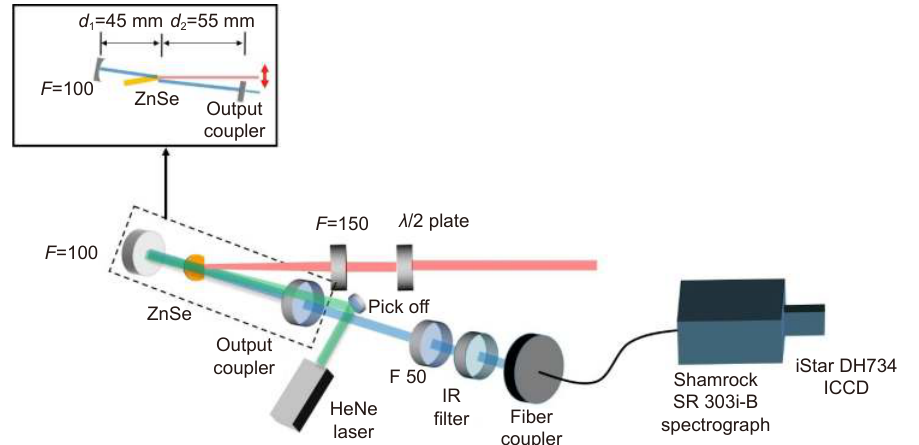
Fig. 15 | Schematic diagram of resonant cavity with spectral analysis. The curved mirror is Aluminium coated ( R > 90 %) while the flat dielectric output coupler had reflectivity R ~ 55% at 475 nm. The arrow in the inset (plan view) shows the linear polarisation direction.